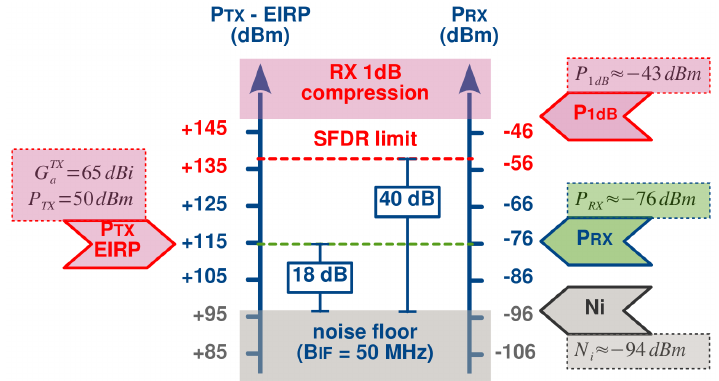
Figure 4. Signal levels. Comparison between transmitted effective isotropic radiated power (EIRP) of the ground station and received power levels at 22.85 GHz. For a link distance of 384.4 × 10 3 km the path loss is − 231 dB, corresponding to Zenith and clear sky conditions. The RX axis also reports the noise floor (for 50 MHz IF bandwidth), the 1 dB compression point and the SFDR